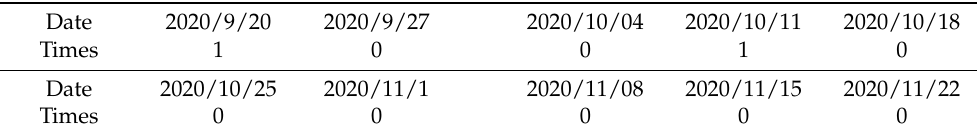
Figure 16. Over-frequency rate results under optimized parameters. Table 14. Statistical results of system failure (number of times per